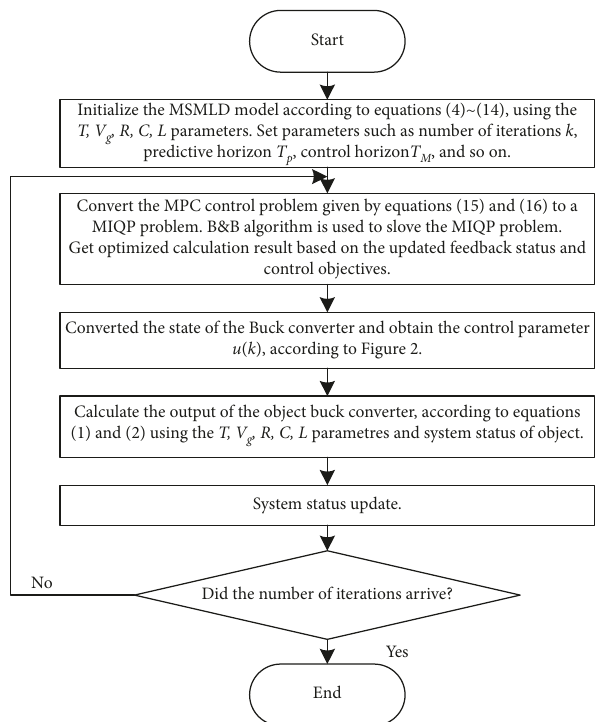
Figure 3: Control flow chart based on the MSMLD